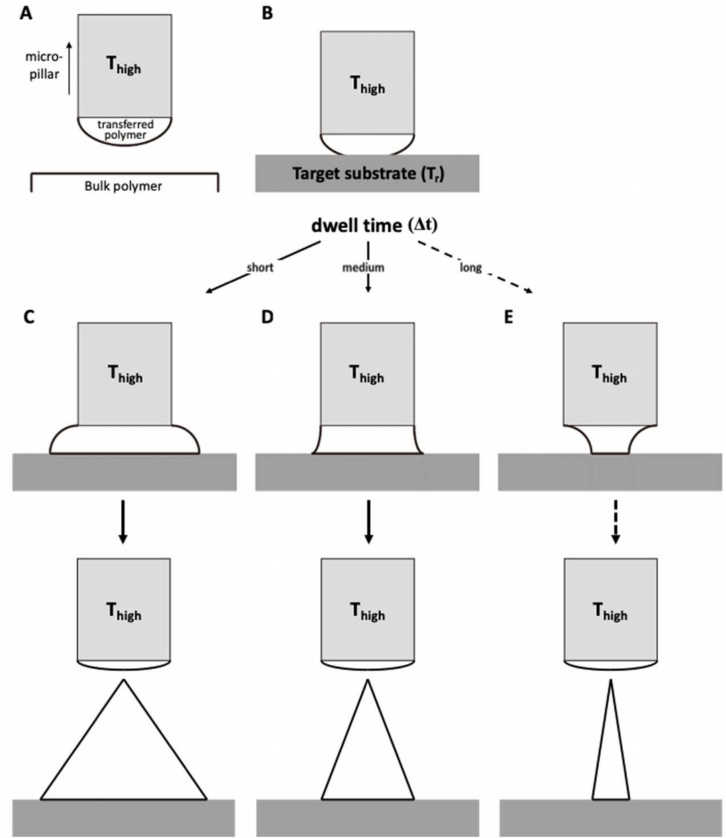
Figure 3. Schematic diagram of ( A ) droplet transfer and ( B ) contact dwelling in transfer thermal drawing process. The shape of the MN via the transfer thermal drawing process can be determined by varying the dwell time to either ( C ) short, ( D ) medium, or ( E )